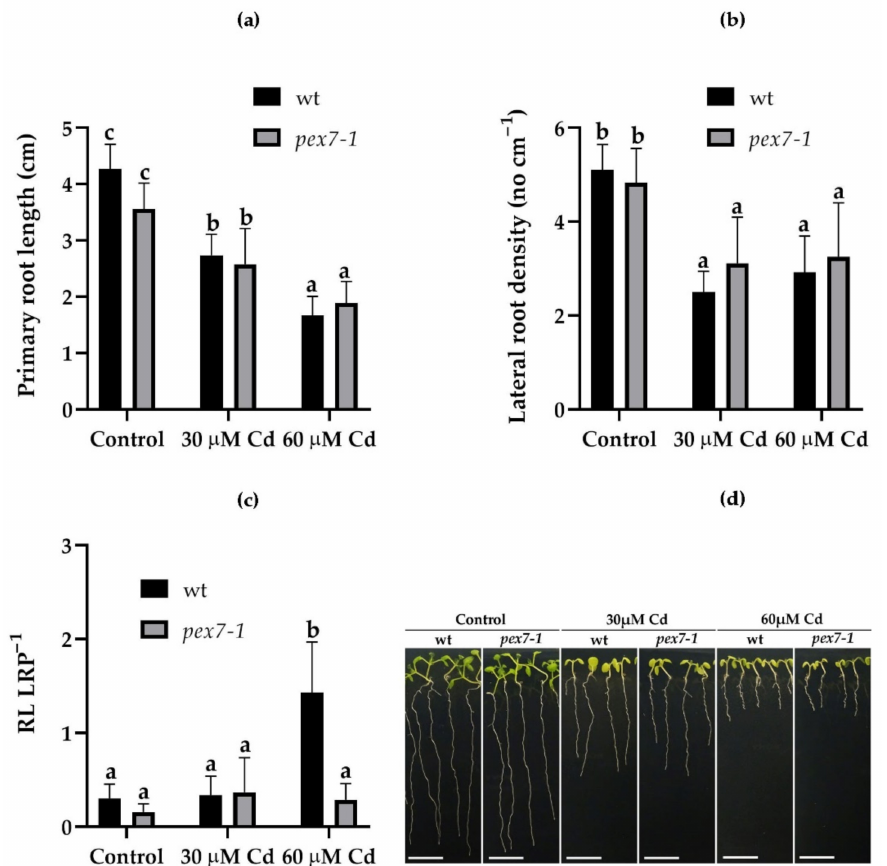
Figure 2. Mean values ( ± SE) (from three biological replicates) of the primary root length ( a ), lateral root density ( b ), of the ratio between the number of mature lateral roots (LR) and the lateral root primordia (LRP) ( c ) and macroscopic images ( d ) of wt and pex7-1 seedlings not exposed (Control) or exposed to 30 µ M CdSO 4 (30 µ M Cd) or 60 µ M CdSO 4 (60 µ M Cd). Columns labelled with different letters show statistical differences for at least p < 0.05 among treatments within the same genotype and between genotypes within the same treatment. Columns labelled with the same letter or with no letter are not statistically different ( p > 0.05). n = 30. Bars = 1